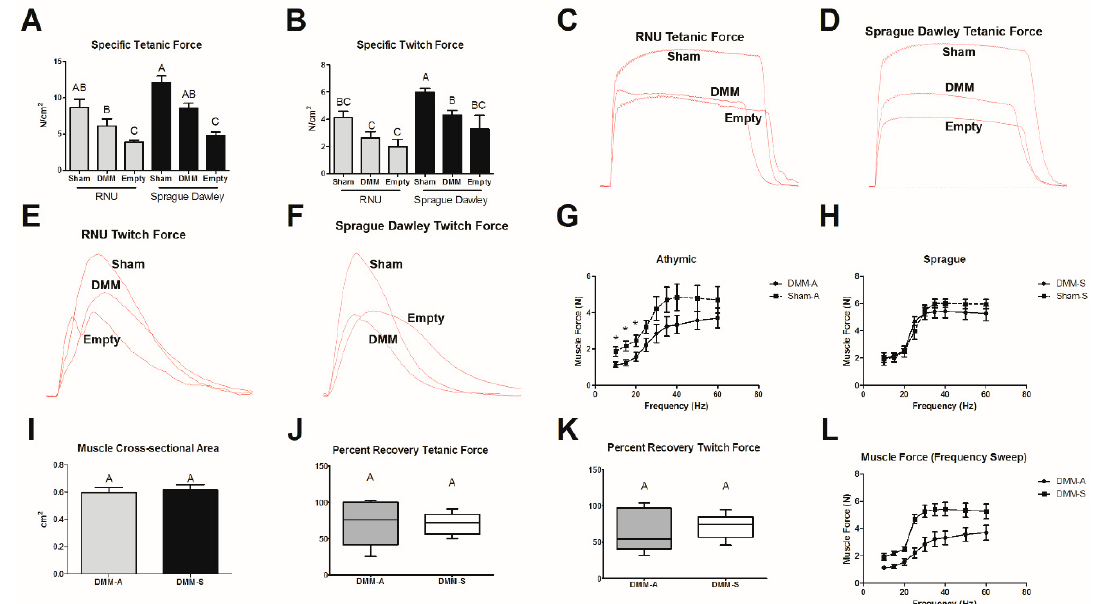
Figure 2. Comparison of muscle force output in RNU and Sprague Dawley rats treated with DMM. Specific tetanic force ( A ) and specific twitch force ( B ) both showed reduced muscle force when DMM-treated sites were compared to sham animals. Tetanic force ( C , D ) and twitch force ( E , F ) show representative force–time curves for each group tested. When animal groups were compared, Sprague Dawley rats produced more force than RNU rats. Force–frequency tests were used to further assess the physiologic differences between DMM and sham-operated animals for RNU ( G ), and Sprague Dawley ( H ) rats. Muscle cross-sectional area ( I ), percent recovery tetanic force ( J ), and percent recovery twitch force ( K ) were unchanged. Force–frequency of DMM-treated sites between RNU and Sprague Dawley rats were compared ( L ). * indicates a difference from sham in ( G ) ( p < 0.05, t -test), Letters not shared indicate a significant difference ( p < 0.05, Tukey). Data shown are means ± SEM of 8 DMM and sham animals and ± SEM of 3 for empty defect animals.